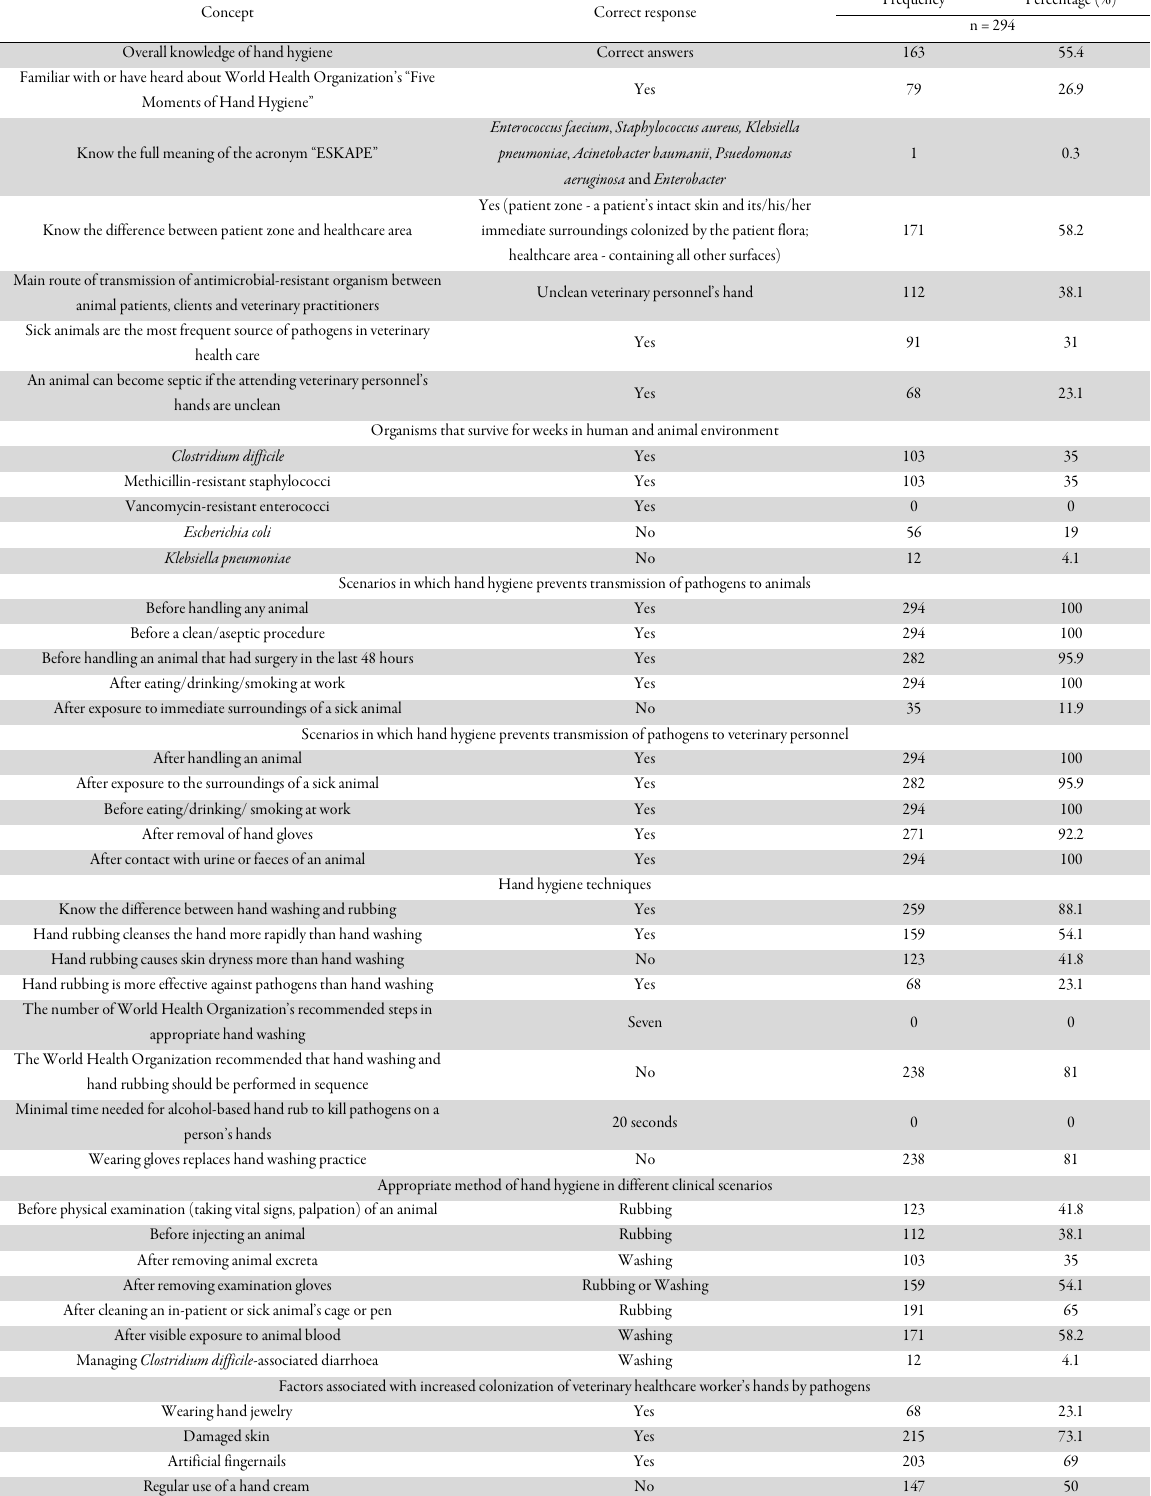
Table 2. Perception/Level of knowledge possessed by veterinarians in the study area about hand hygiene